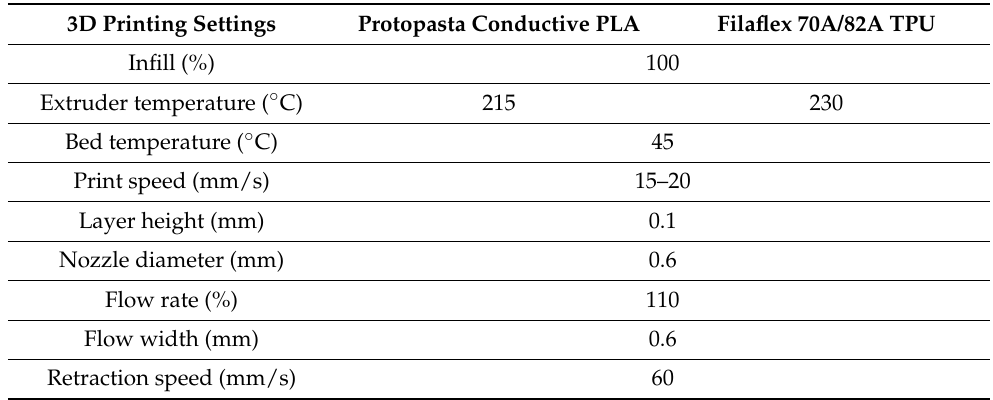
Table 1. Printing parameters applied for the 3D printing of the different